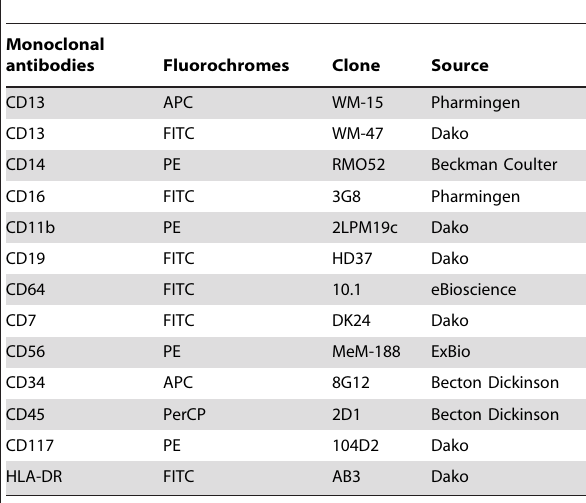
Table 1. Antibodies used in the panel, with clones and